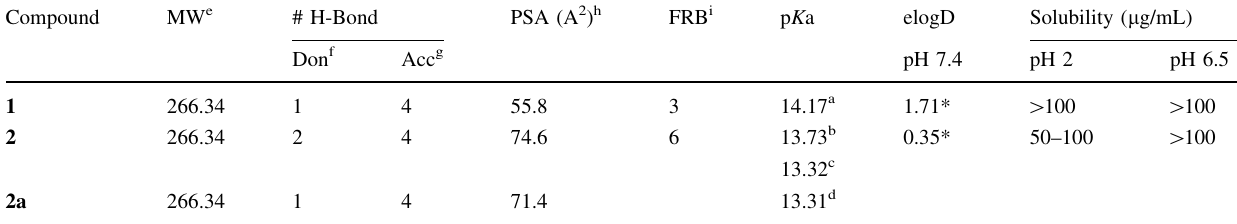
Table 5 Summary of the physicochemical data for 1 , 2 and 2a